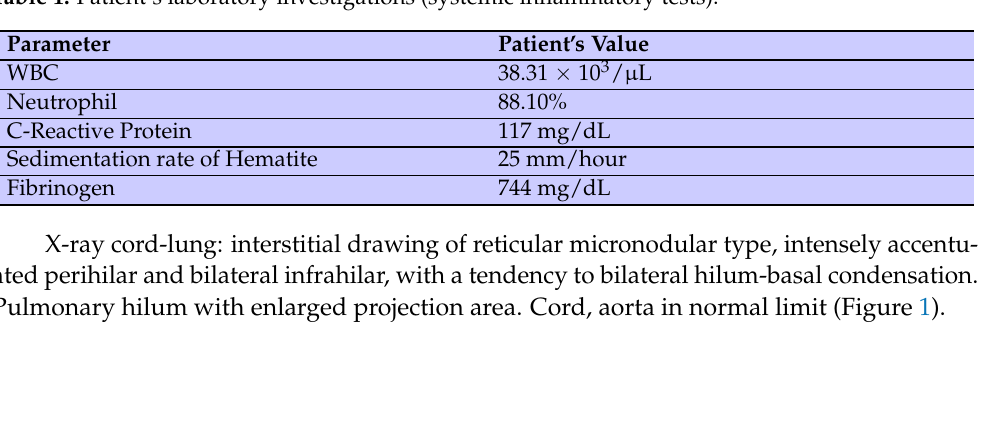
Table 1. Patient’s laboratory investigations (systemic inflammatory tests).